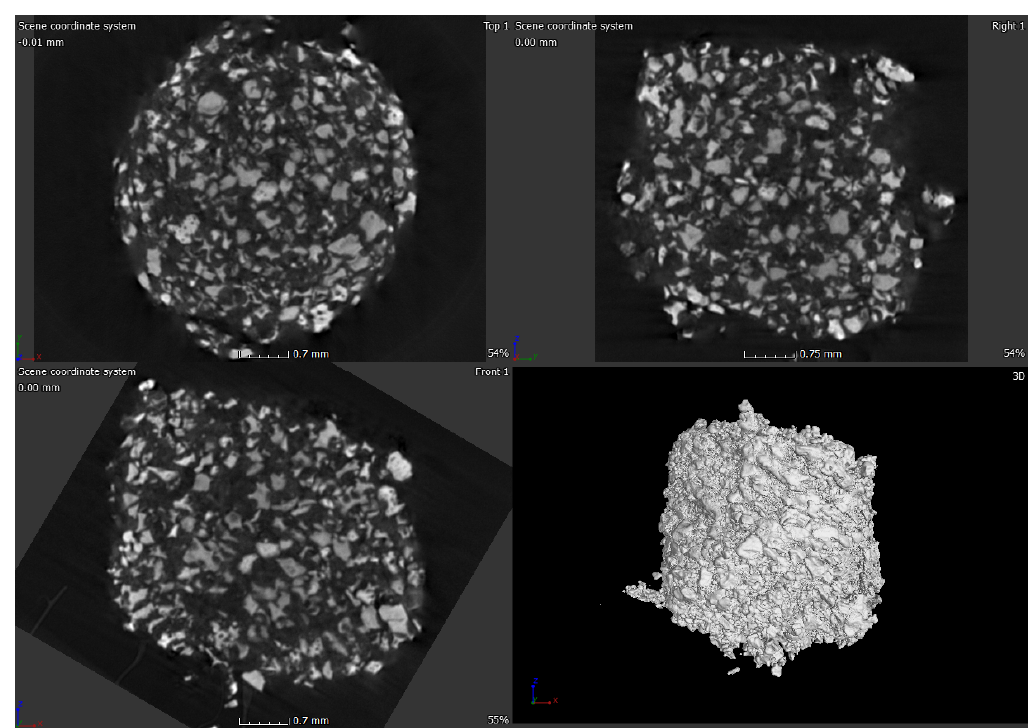
Figure 7. µ-CT image of ABVF putty. BG particles appear to be homogenously distributed in the polymer matrix.